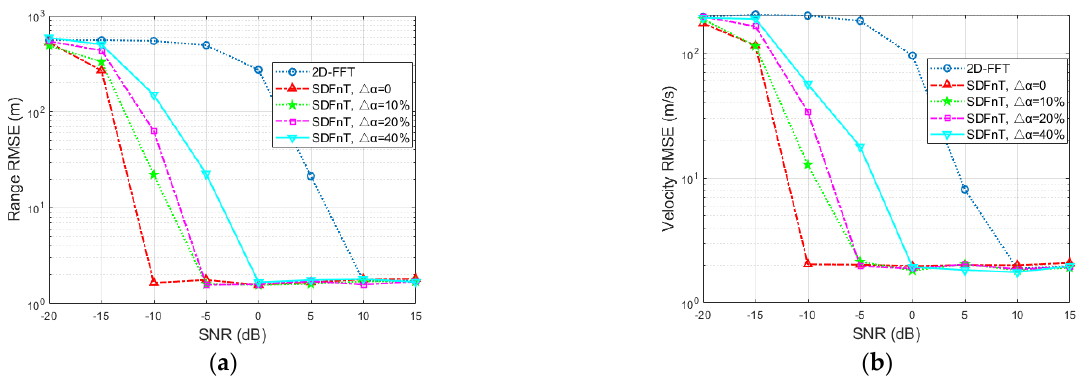
Figure 5. Single-target results in terms of SNR ( a ) RMSE for the range estimation ( b ) RMSE for the velocity estimation.